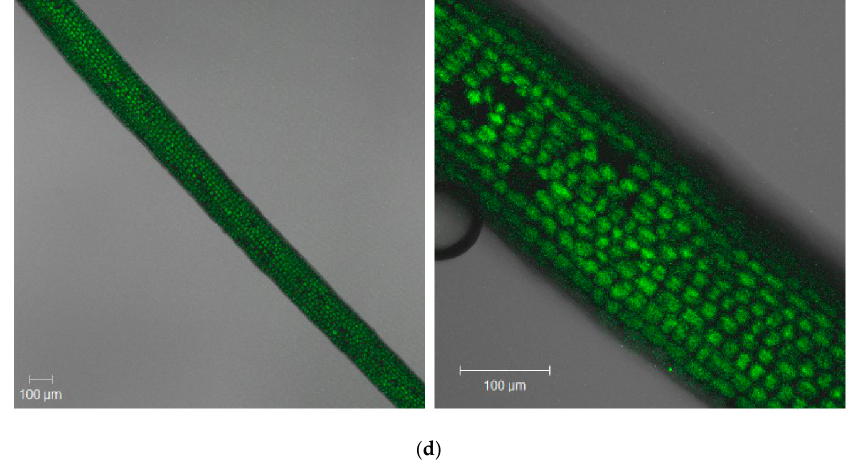
Figure 3. Relative generation and cytochemical localization of hydrogen peroxide in leaves of one- ( a ) and two-month-old plants ( b ) of Asparagus officinalis L. cv. Argenteuil infested by Brachycorynella asparagi (Mordv.) at a varied population size (10, 20, and 30 aphids per plant); 48-h leaves of Asparagus officinalis one-month-old plants infested by 30 aphids B. asparagi per plant ( c ); and 96-h leaves of Asparagus officinalis two-month-old plants infested by 30 aphids ( d ). Green fluorescence originating from DCFH-DA (dichlorodihydro-fluorescein diacetate) was observed under a Zeiss LSM 510 confocal microscope (objective magnification of 20× for a , b and 5× and 20×, respectively, for c ). Scale bar 100 µm ( a – d ).